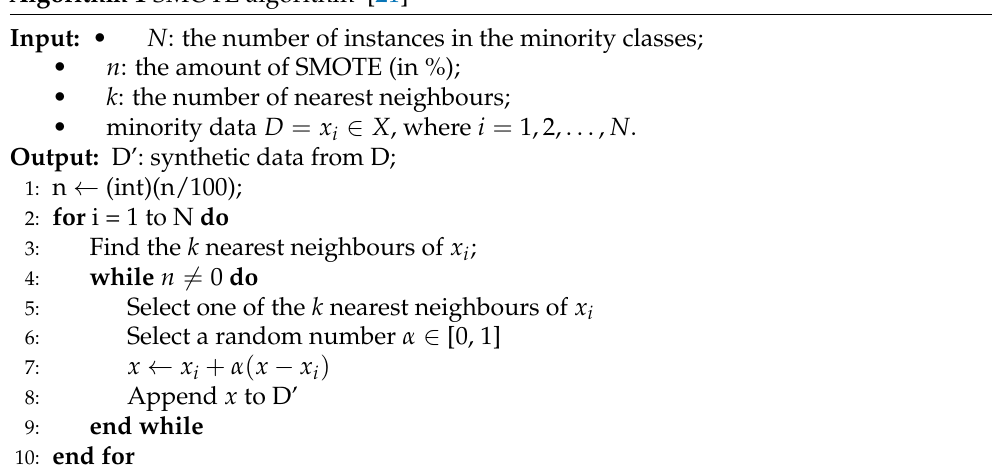
Algorithm 1 SMOTE algorithm